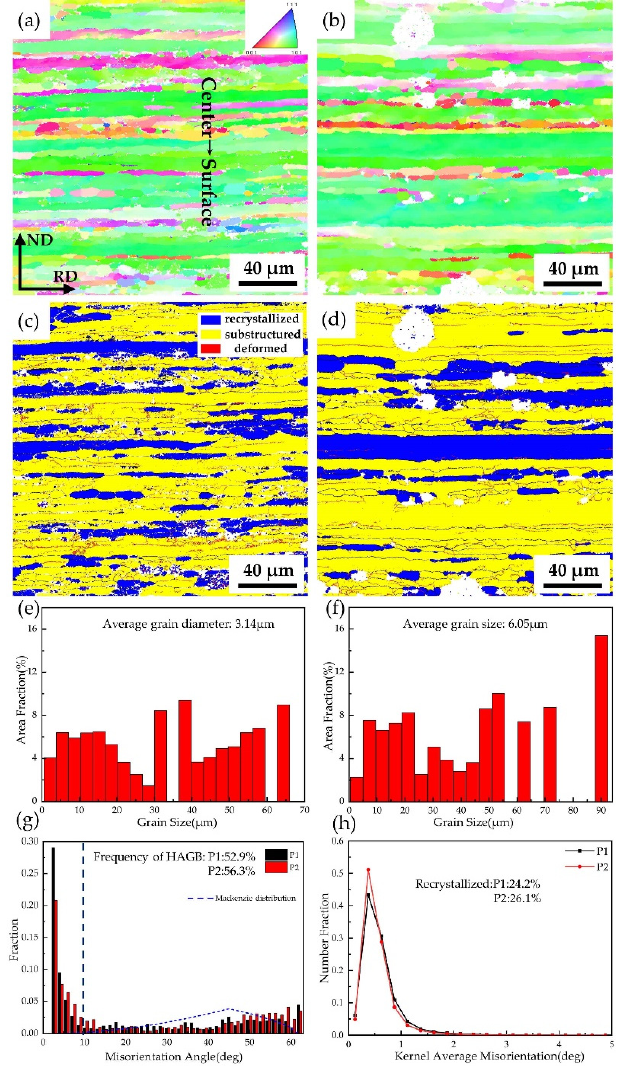
Figure 8. EBSD-derived images of the P1 and P2 sample: ( a , b ) Inverse pole figure (IPF) map viewed along TD direction; ( c , d ) Corresponding grain orientation spread (GOS) map, deformed, substructured, recrystallized in red, yellow and blue, respectively; ( e , f ) grain diameter distributions; ( g ) Grain boundary misorientation distributions; ( h ) kernel average misorientation map. The Macken- zie distribution is plotted as a blue dotted line in ( g ).